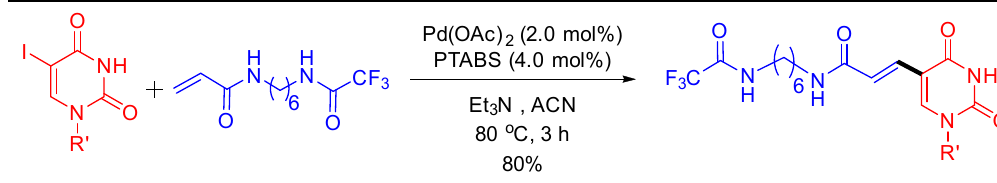
Figure 7. Improvement in the synthesis of Ruth linker.